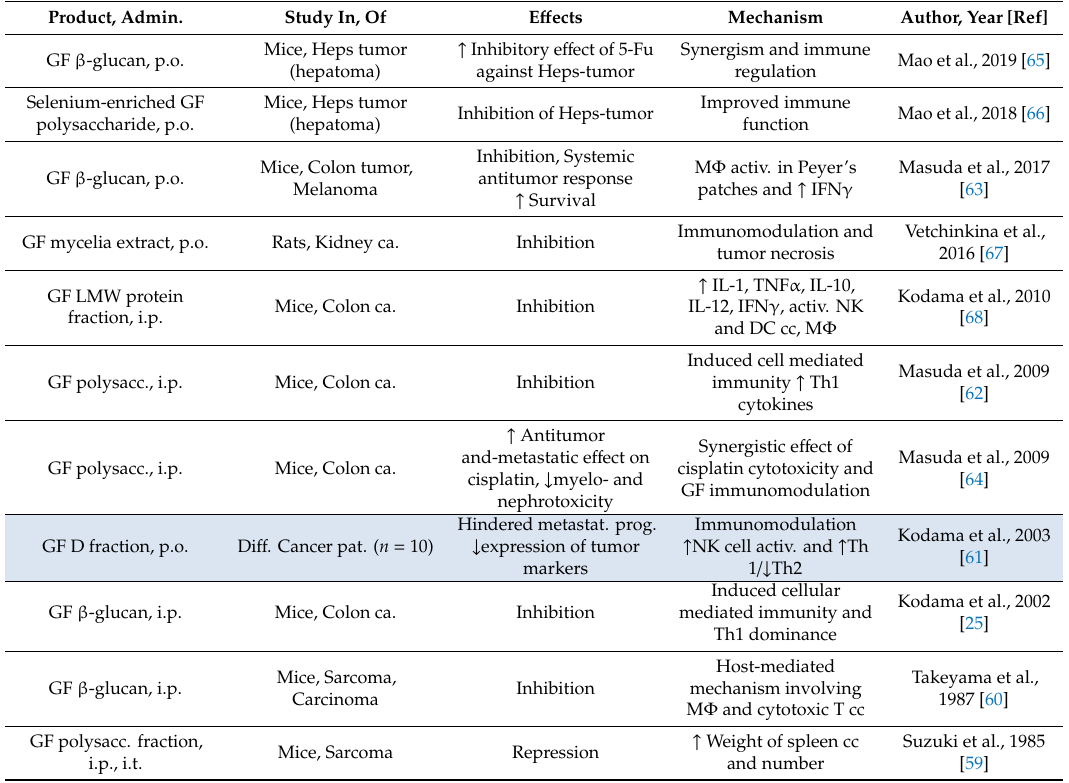
Table 3. Antitumor e ff ect of Grifola fondosa (Human study)